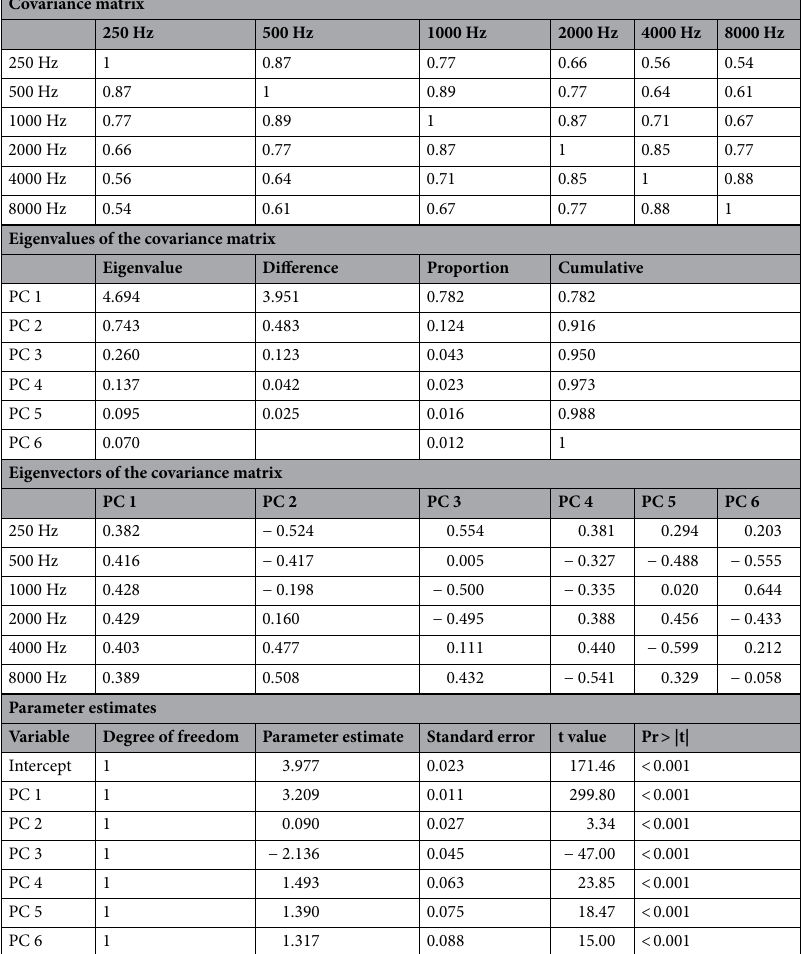
Table 2. Principle component analysis on the 6 threshold values of each audiogram followed by the REG procedure with WRS as outcome variable and the 6 principal components as predictors, selected by stepwise regression.